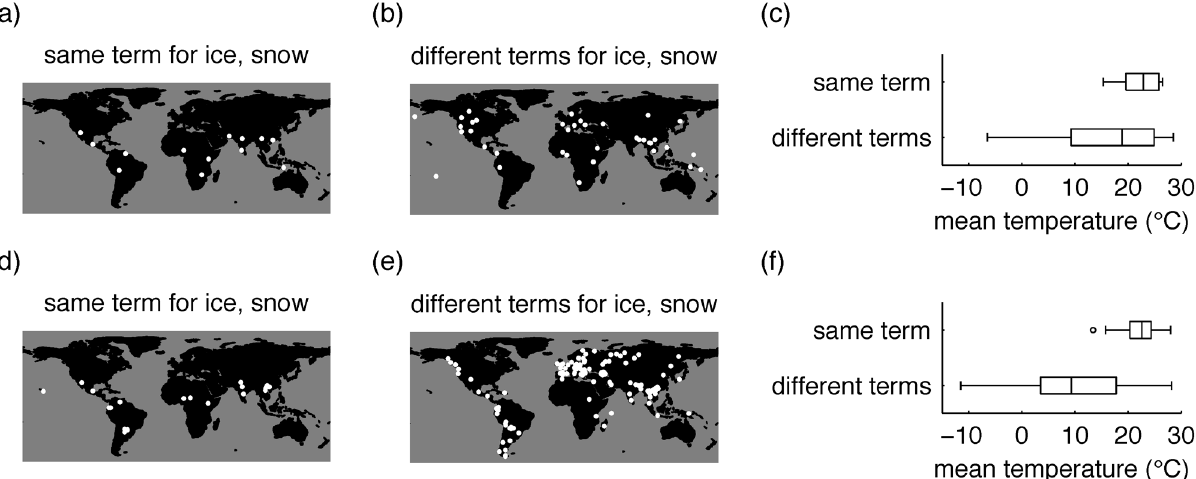
Fig 1. Results of cross-language surveys. Top panels: Library survey. (a) Locations associated with 13 languages that use the same term for ice and snow, and (b) 37 languages that use different terms. (c) Temperatures associated with the locations shown in (a) and (b). Bottom panels: IDS+ data. (d) Locations associated with 21 languages that use the same term for ice and snow, and (e) 145 languages that use different terms. (f) Temperatures associated with the locations shown in (d) and (e). Map data for this and all subsequent figures are from naturalearthdata.com.